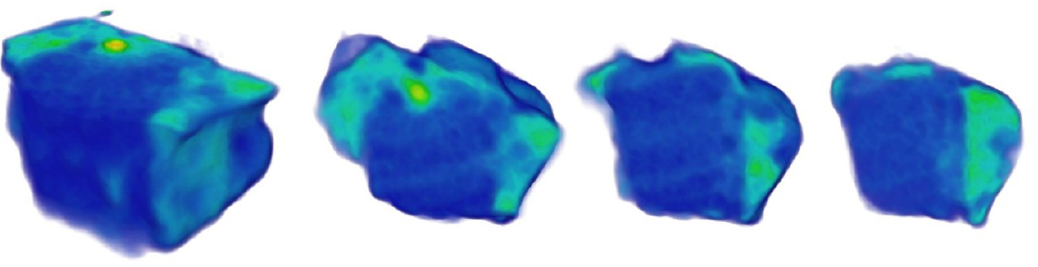
Figure 8. The reconstructed 3D model and several virtual slices of the mosaic fragment sample 6. It is assumed the blue areas correspond to calcite phase; the green-yellow regions are hydrates or other hydrogen-contained areas inside the mosaic fragment. The rainbow-like coloring shows neutron absorption degree from low (blue) to high (green).